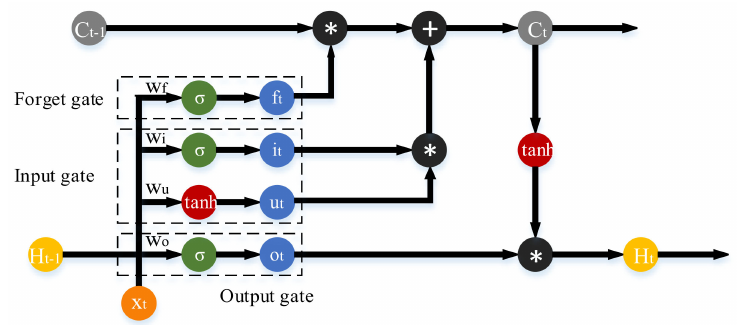
Figure 4. The illustration of a basic